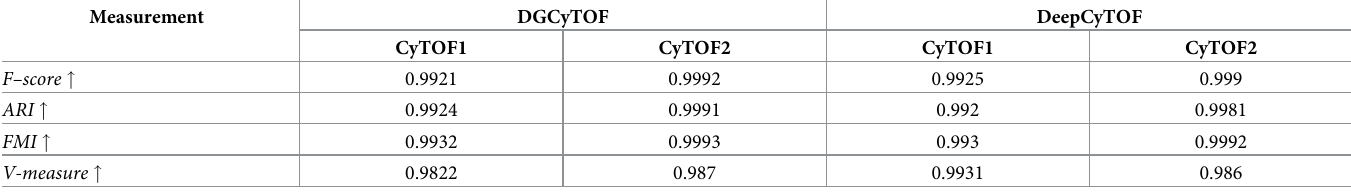
Table 3. Comparison of methods for averaging performance in the identification of known cell types in training and testing data by different measurements for CyTOF1 and CyTOF2 datasets.